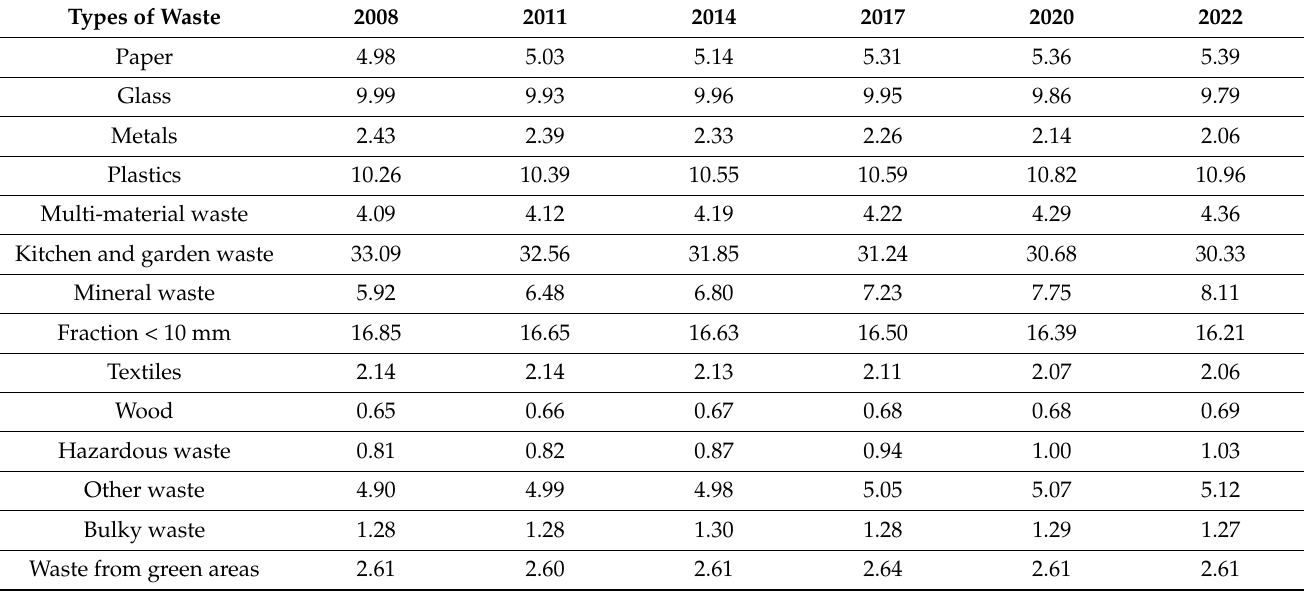
Table 4. Projected changes in the morphological composition of municipal waste from rural areas (%) [63].